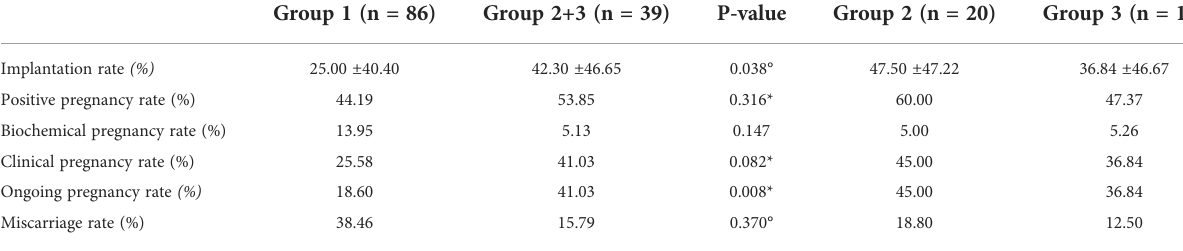
TABLE 2 Comparison of reproductive outcomes between the groups according to the progesterone